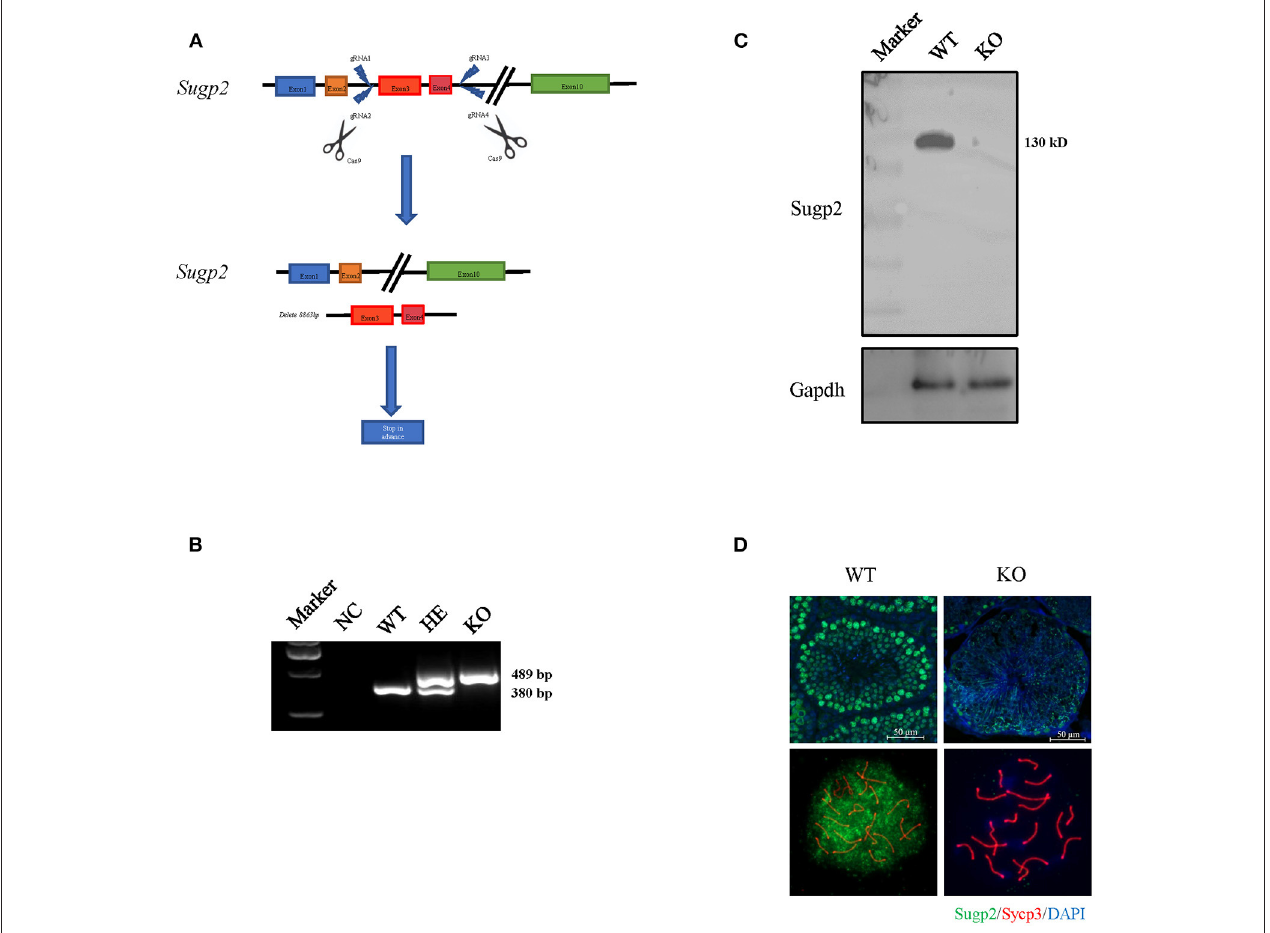
FIGURE 4 | Generation of Sugp2 knockout mouse. (A) Knockout strategy of Sugp2. Exons 3 and 4 were deleted by the CRISPR/Cas9 genome editing system. (B) Mouse genotype identification by mouse tail PCR. WT, wild type; HE, heterozygote; KO, knockout. Western blot (C) and immunofluorescence staining (D) of Sugp2 in adult WT and Sugp2 KO testes. n , number of samples per